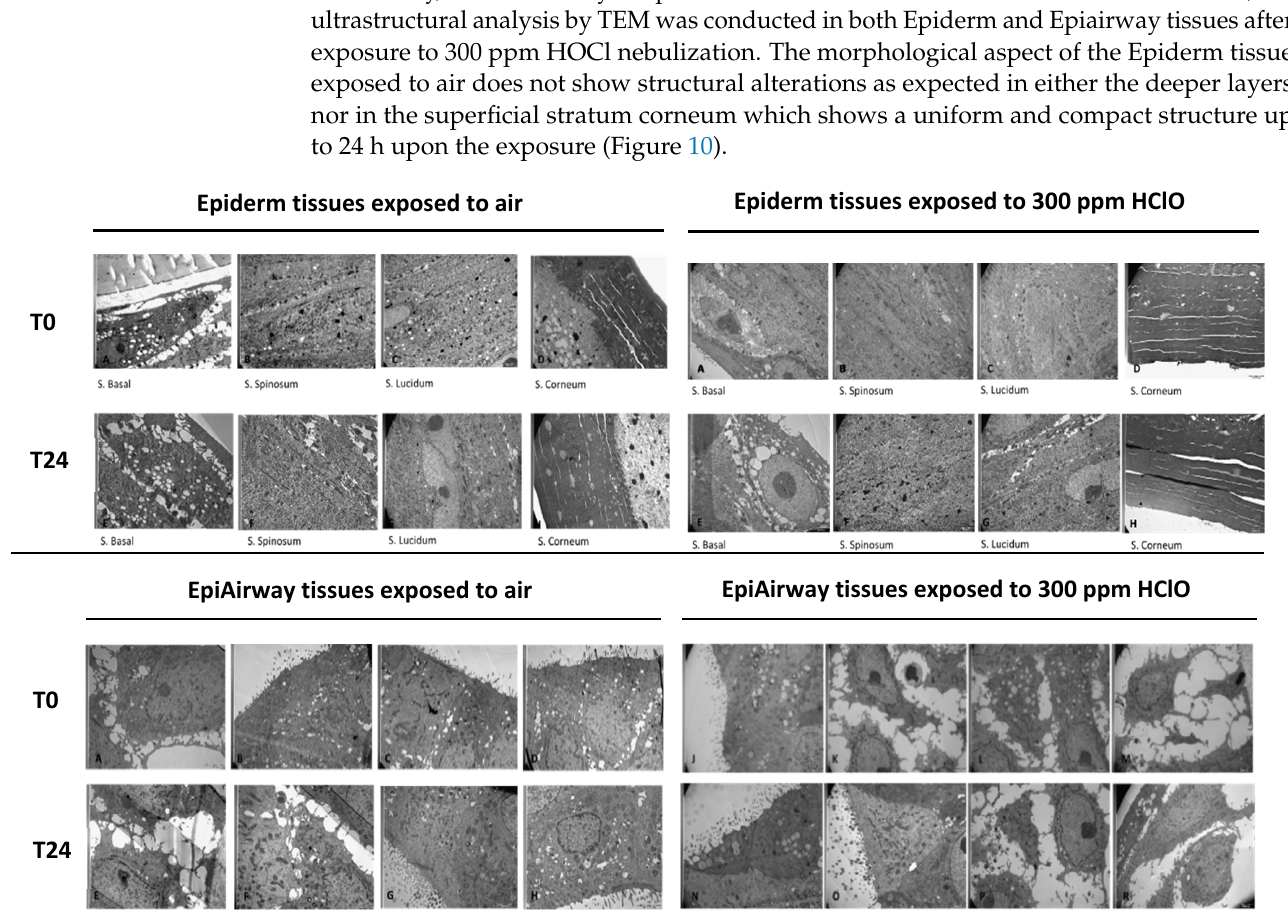
Figure 9. Epiderm ( A ) and Epiairway ( B ) tissue morphology evaluation by hematoxylin–eosin staining in control tissues and in tissues immediately after or 24 h after 300 ppm HOCL nebulization. Magnification 40×.